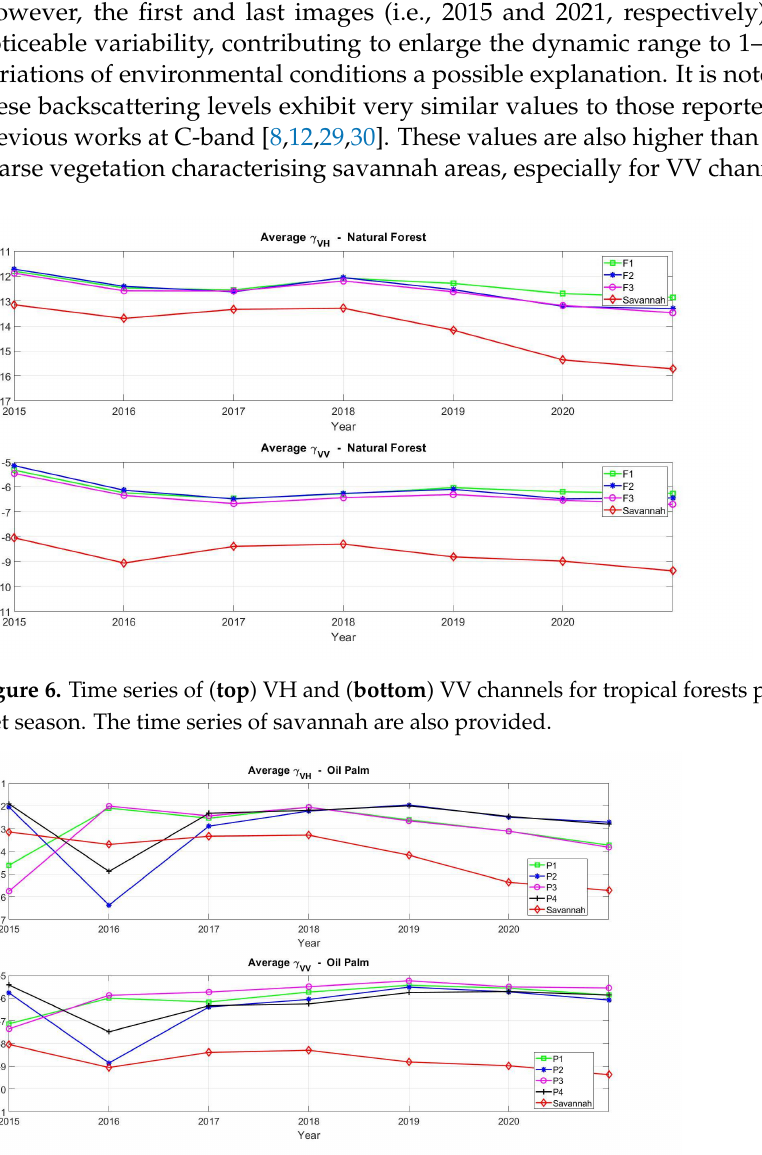
Figure 7. Time series of ( top ) VH and ( bottom ) VV channels for oil palm polygons during the wet season. The time series of savannah are also